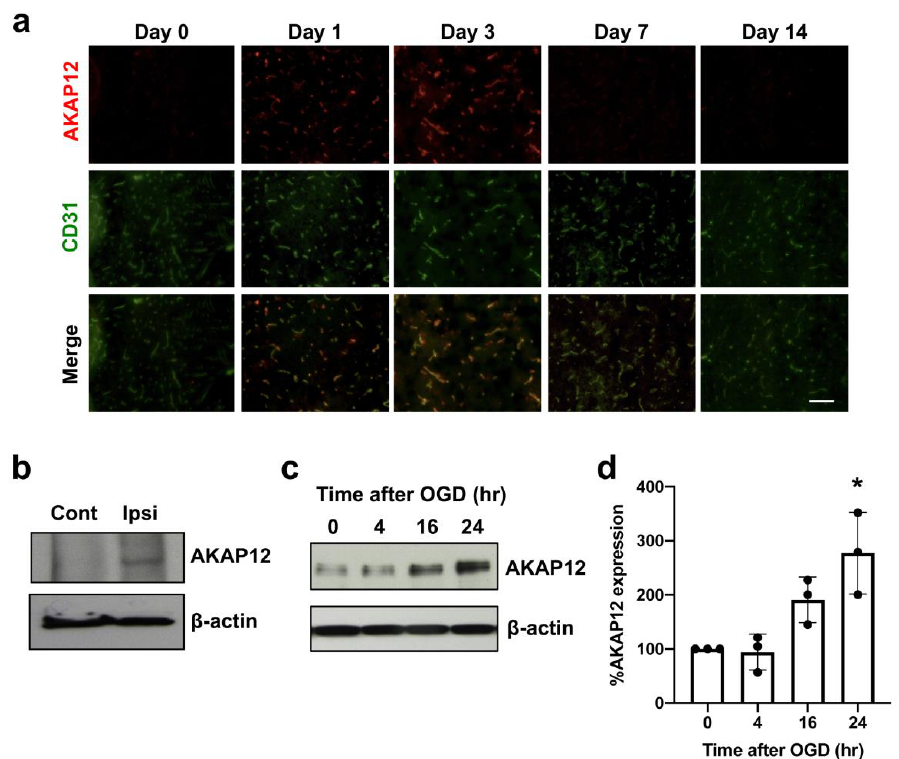
Figure 1. AKAP12 expression after stroke: ( a ) Double-staining of AKAP12 (red) with an endothelial marker CD31 (green) showed that AKAP12 was expressed in or around blood vessels, and its expression level transiently increased after stroke. Scale bar = 50 um. ( b ) Western blot using endothelial fractions from stroke mice confirmed that compared to the contralateral hemisphere (Cont), AKAP12 level was elevated in the brain endothelium of the ipsilateral hemisphere (Ipsi) at 3 days after stroke. ( c – d ) In HBMECs, OGD/Reoxygenation stimulation, an in vitro model to mimic in vivo cerebral ischemia-reperfusion, induced an upregulation of AKAP12. Mean ± SD of n = 3. * p < 0.05 vs control (0 hr after OGD). Kruskal-Wallis test followed by post-hoc Dunn’s multiple comparison test.